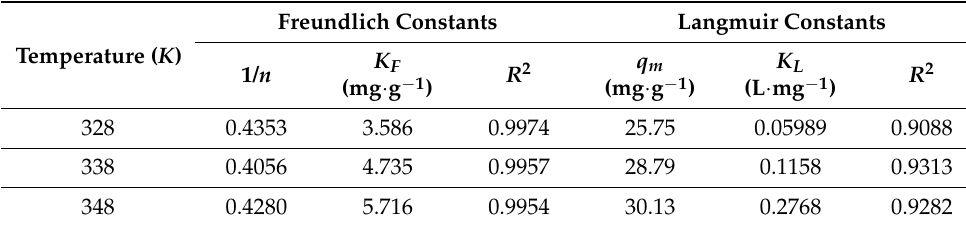
Table 1. Adsorption isotherm parameters of calcium ions onto RMCRs.